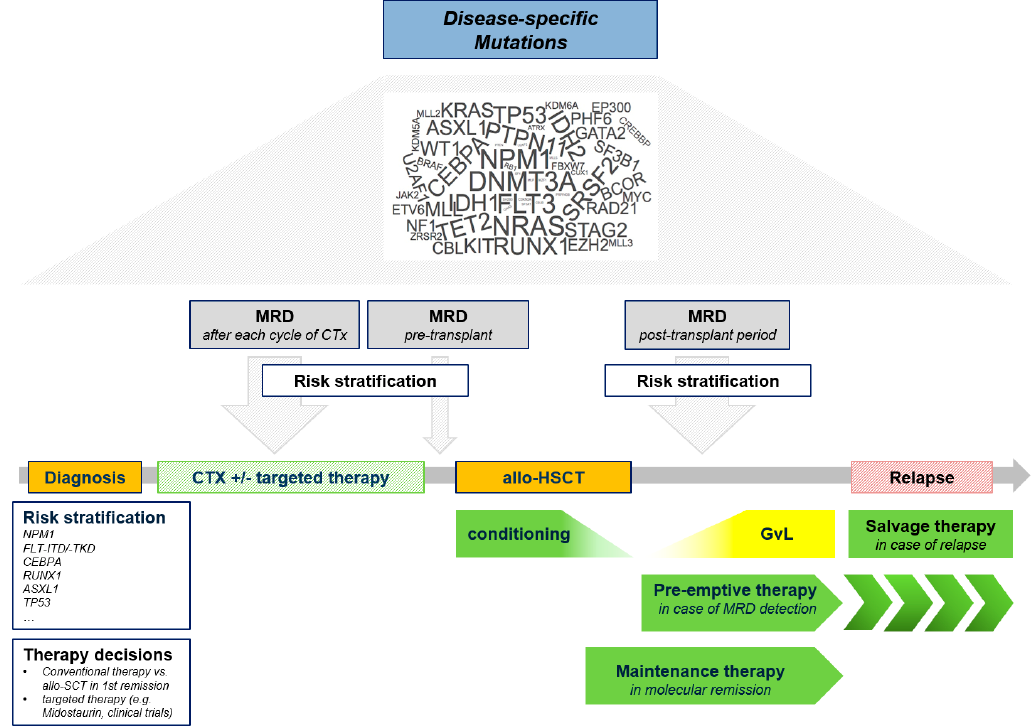
Figure 1. Clinical use of molecular information to prevent, detect, and treat relapse after allogeneic stem cell transplantation (allo-SCT). MRD (minimal or measurable residual disease); NPM1 (Nucleophosmin); FLT3-ITD (FMS-like tyrosine kinase 3-internal tandem duplication); FLT3-TKD (FMS-like tyrosine kinase 3-tyrosine kinase domain); CEBPA (CCAT/enhaner-binding protein alpha); RUNX1 (Runt-related transcription factor 1); ASXL1 (additional sex comb-like 1); TP53 (Tumor Protein 53); allo-SCT (allogeneic stem cell transplantation); GvL (Graft-versus-Leukemia); CTx (Chemotherapy).